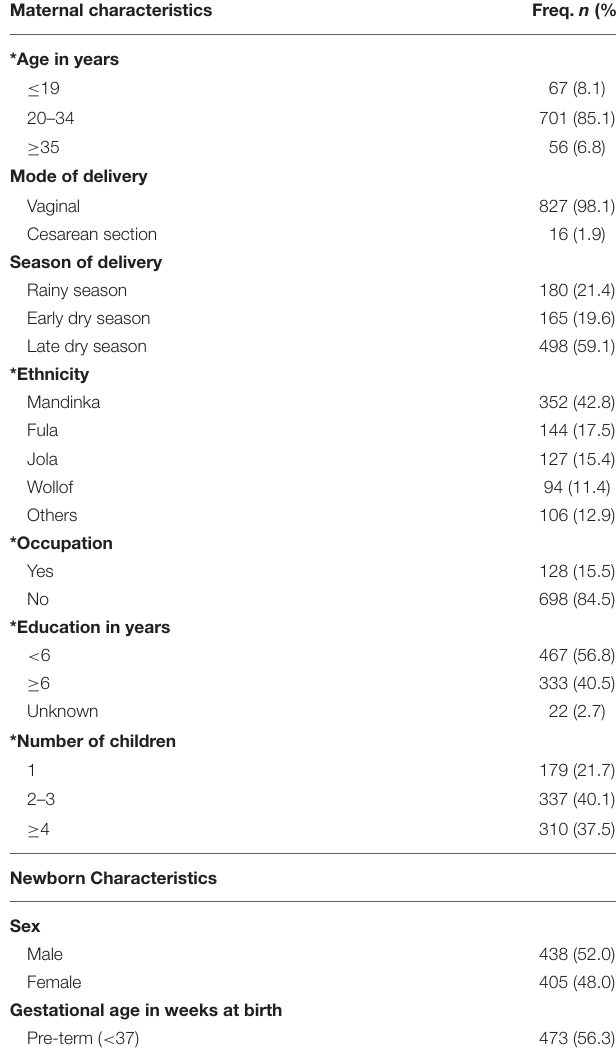
TABLE 1 | Baseline characteristics of mothers ( N = 829) and their newborns ( N = 843). Maternal characteristics Freq. n